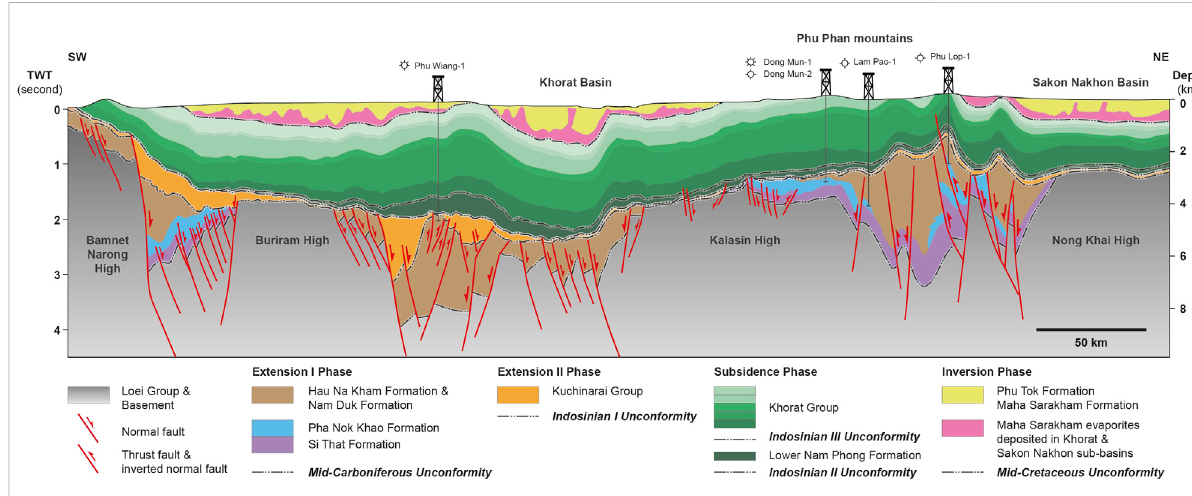
FIGURE 5 StratigraphiccrosssectionsacrosstheKhoratPlateau,showingthemajorlithologicalandtectonicunitsinthesubsurface(modi fi edfromBooth and Sattayarak, 2011; Minezaki et al., 2019). The distribution of the Khorat and Sakon Nakhon basins is also shown in this